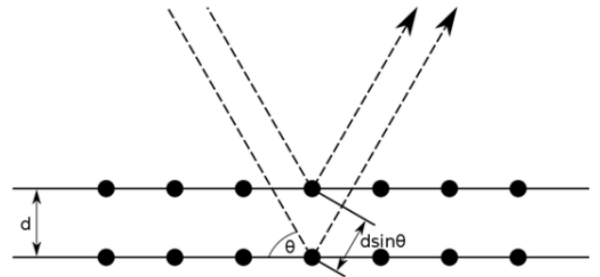
Figure 14. Diffraction of an X ‐ ray beam from a sample [63].